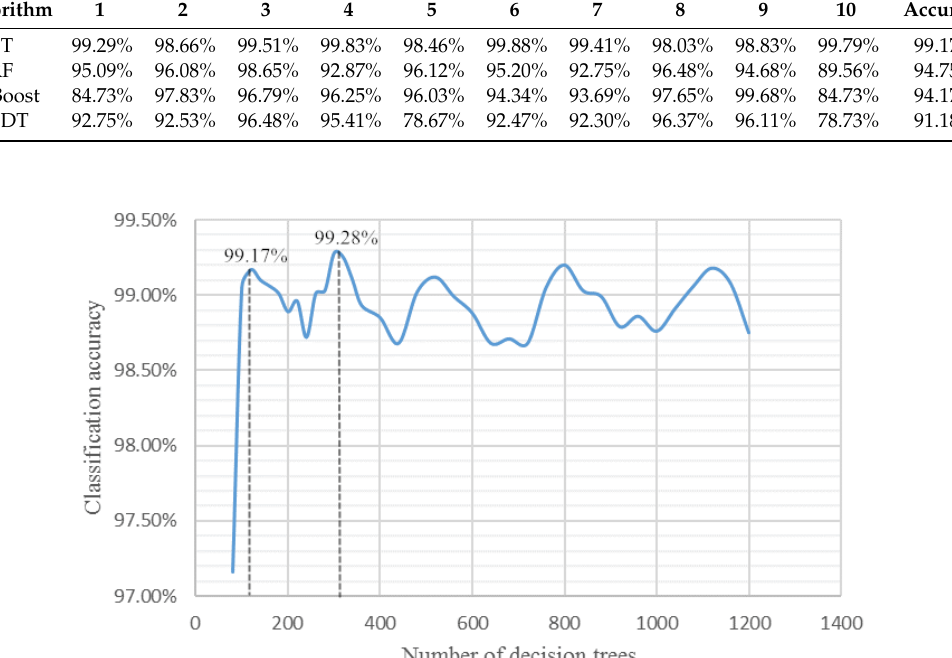
Figure 10. Algorithm classification accuracy comparison. GBDT: Gradient boosting decision tree; XGboost: extreme gradient boosting; RF: random forests; ET extreme random tree. Table 3. Algorithm classification accuracy ratio comparison data.